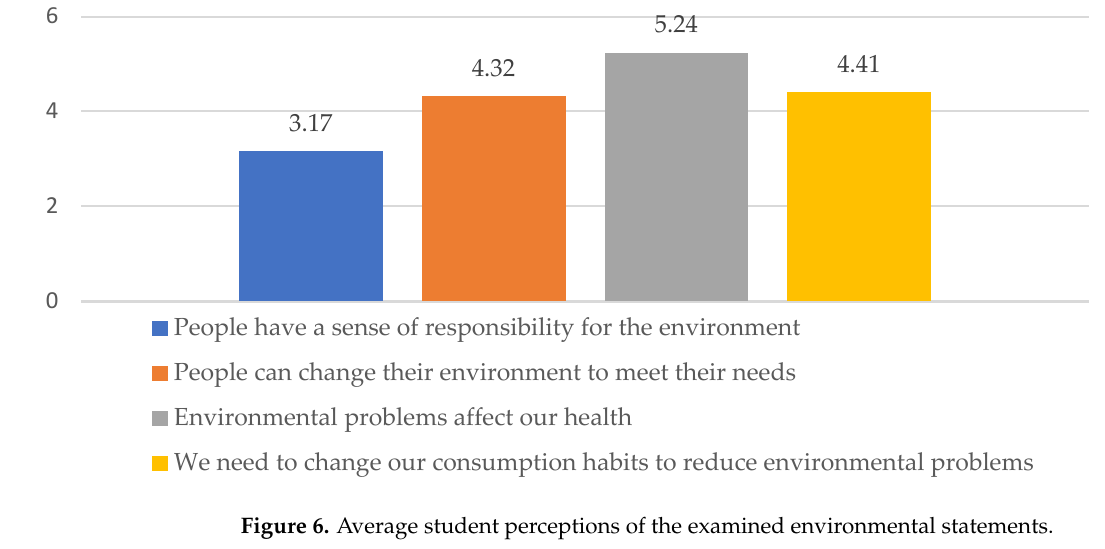
Figure 6. Average student perceptions of the examined environmental statements.